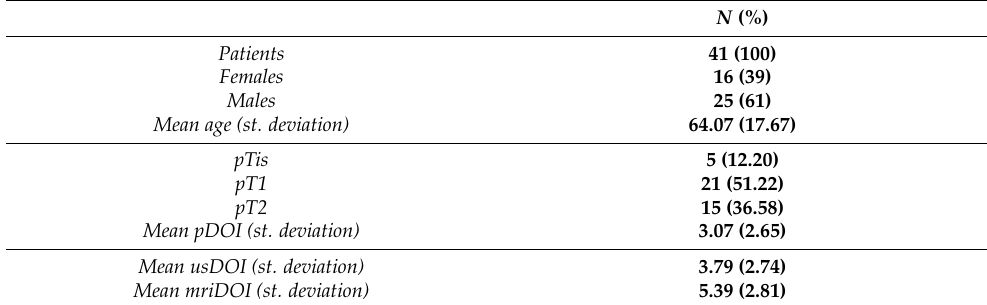
Table 2. Clinicodemographic data of patients included in the study.